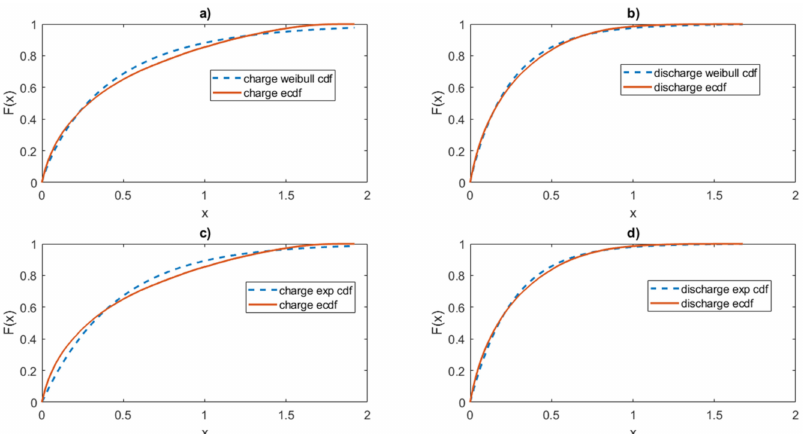
Figure 8. Graphical comparations between Weibull ( a ) and ( b ) and Exponential ( c ) and ( d ) cdf and ecdf for the 1% limitation charge and discharge vectors.